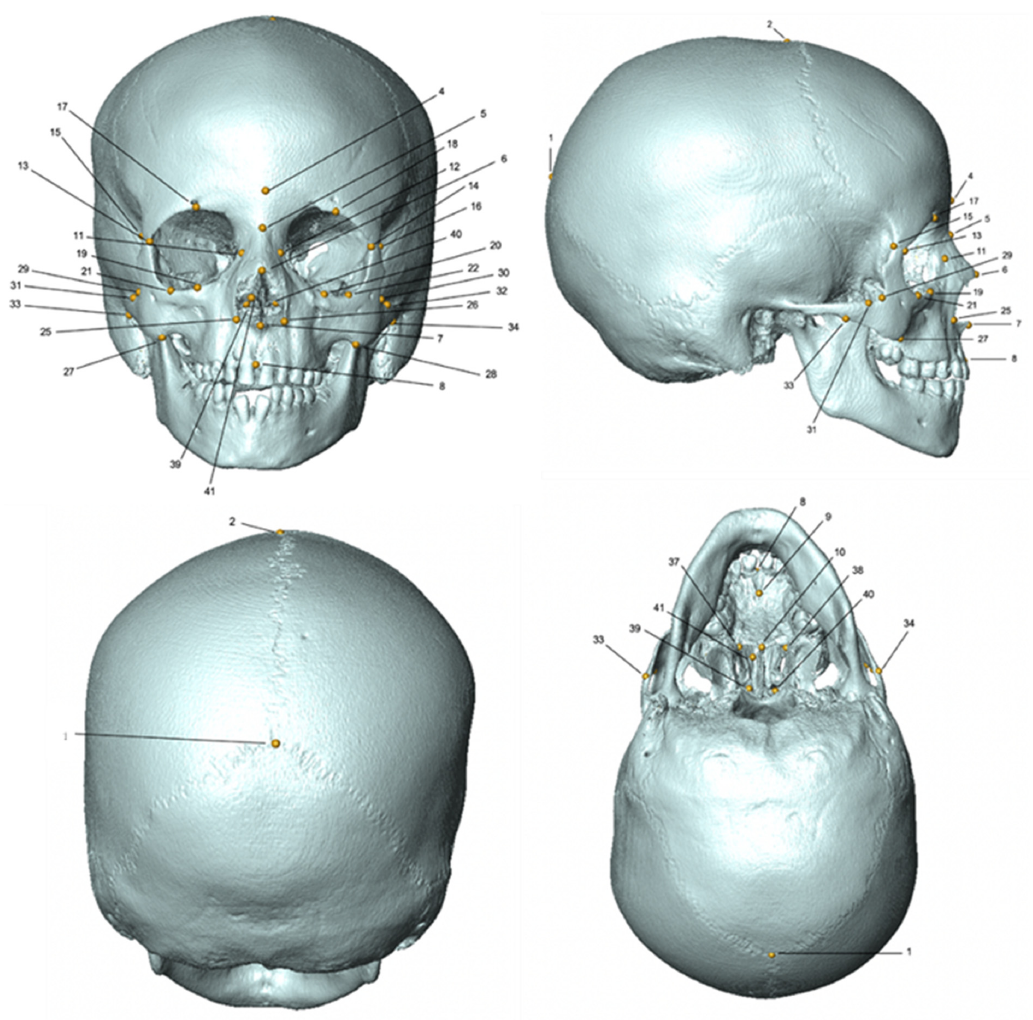
Figure 1. Three-dimensional landmark configuration displayed on one of the male skulls: Frontal view top left, lateral view top right, posterior view bottom left, inferior view bottom right. The landmark numbers refer to the definitions in Appendix B. Image created using Avizo 9.0 (FEI visualisation).